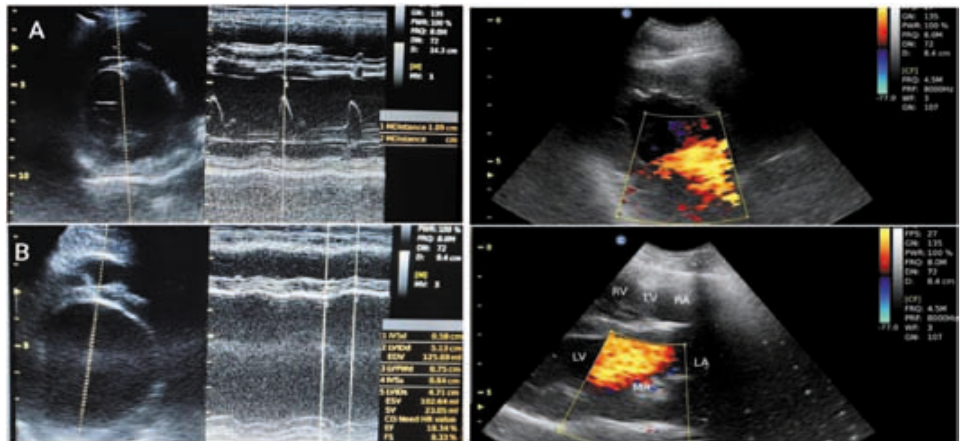
Fig2. Echocardiogram in Dogs- A. Increased EPSS and B. Dilated Ventricle seen in a dog with severe signs Congestive heart failure (CHF). Mitral regurgitation (MR) seen by mosaic pattern of colour (picture on the right side) in a dog with the complaint of cough and exercise